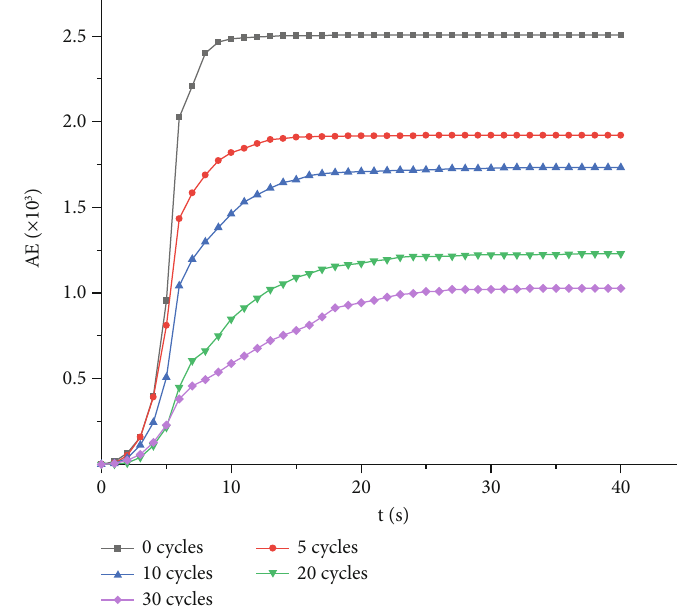
Figure 13: Accumulative energy curve of acoustic emission of sandstone under di ff erent freeze-thaw